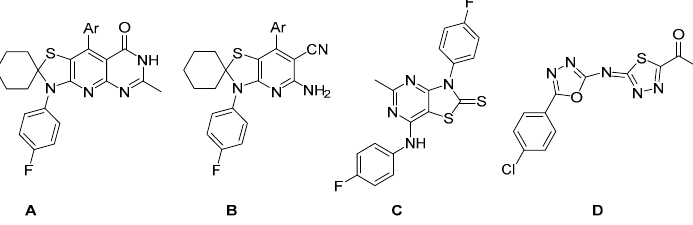
Figure 1. Anticancer spiro-thiazolidine ( A and B ), thiazolopyrimidine ( C ) and 1,3,4-thiadiazole ( D ) compounds.